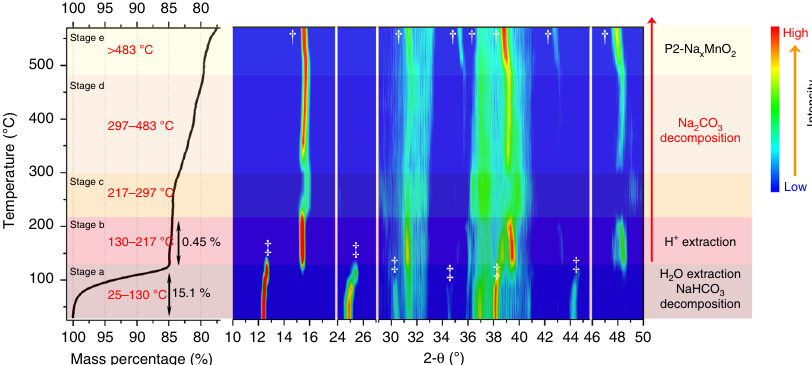
Fig. 6 Temperature-resolved in situ XRD of the totally hydrated Na 0.67 MnO 2 . The temperature ranges from 25 to 570 °C. The TGA curves are shown at the left. Hydrated and P2 phases are labeled with “‡” and “†” , (stage a ) to the protonated phase (stage b ), the combined